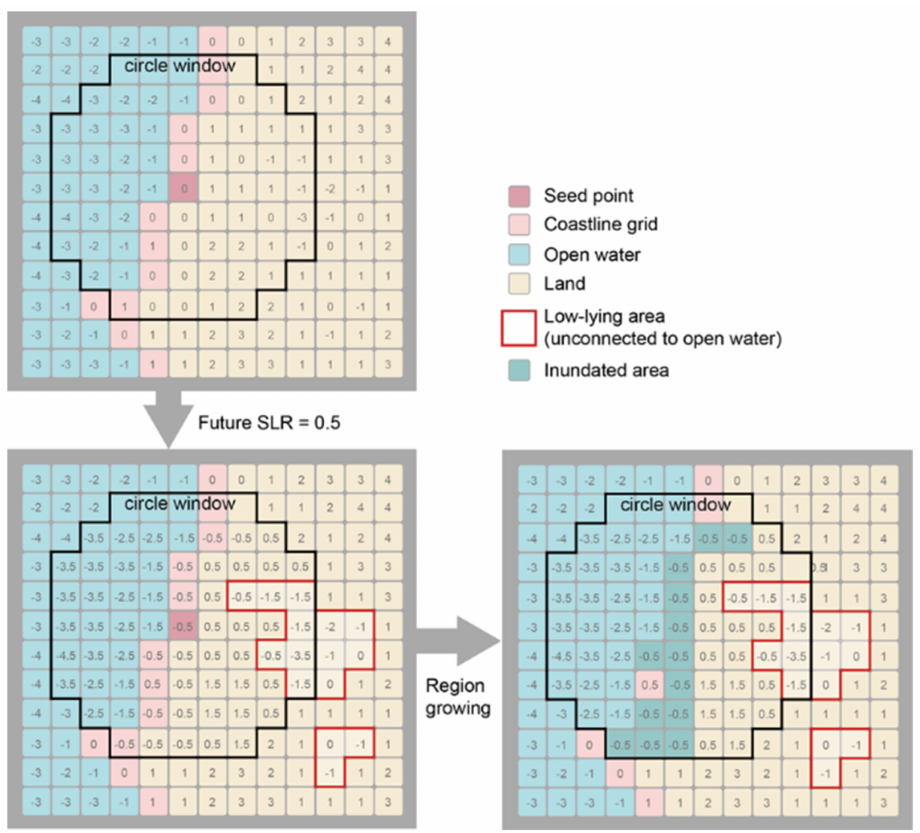
Figure 5. The procedure of the modified region growing